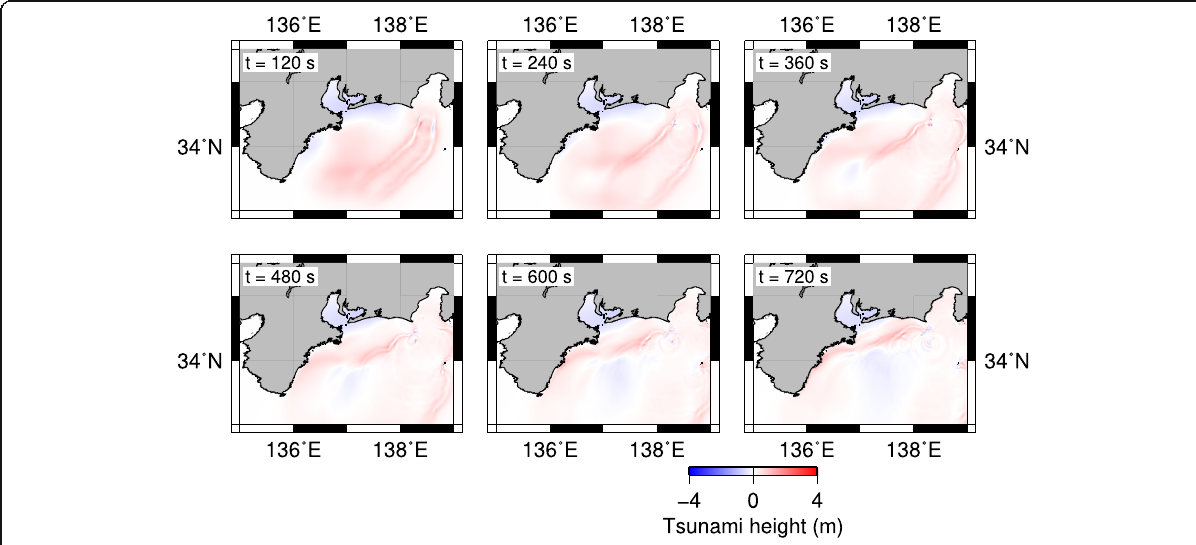
Fig. 10 Snapshots of tsunami propagation for the uniform slip distribution